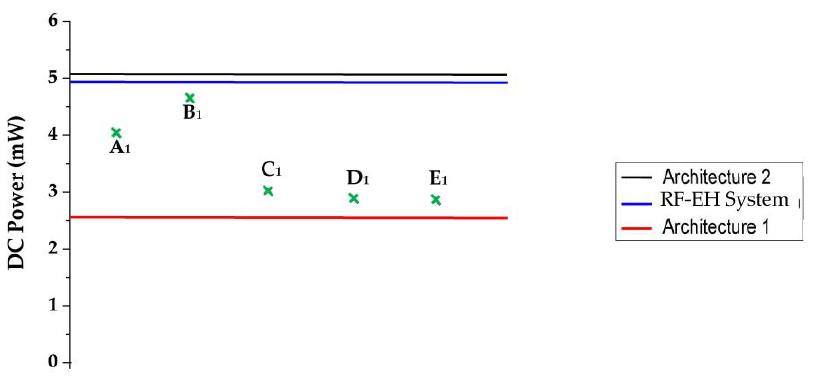
Figure 31. Feeding ability of the system and both architectures at 22 m from relay antenna compared to minimum required power supply of the gas sensors. The DC powers A 1 , B 1 , C 1 , D 1 and E 1 correspond to the power supply of sensors given in the references [26–30], respectively .